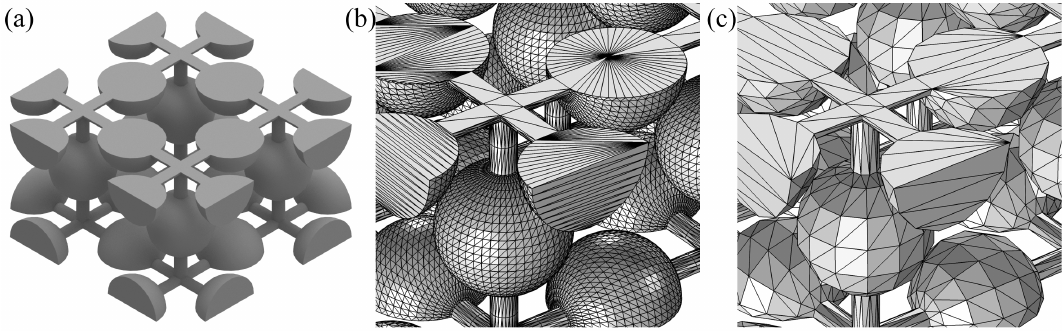
Figure 2. Exemplary STL triangle meshes for ( a ) a 2 × 2 × 1 crystal lattice with ( b ) high resolution of curved surfaces and ( c ) too low resolution with surface deviations larger than fabrication